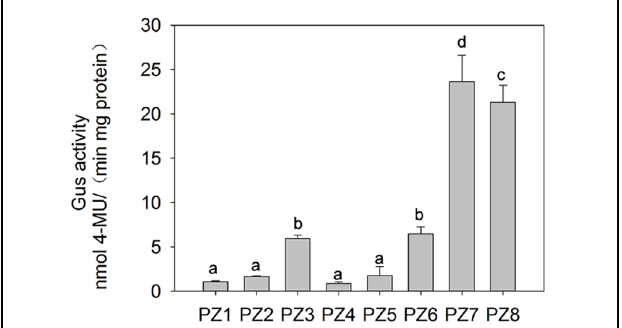
FIGURE 3 | Fluorometric GUS assays of PZ1–PZ8 transgenic tobacco plants. The values are the mean ± standard deviation from three independent transgenic lines and each line five individual plants for each construct. Different lowercase letters above the bars indicate significant differences at P < 0.05.